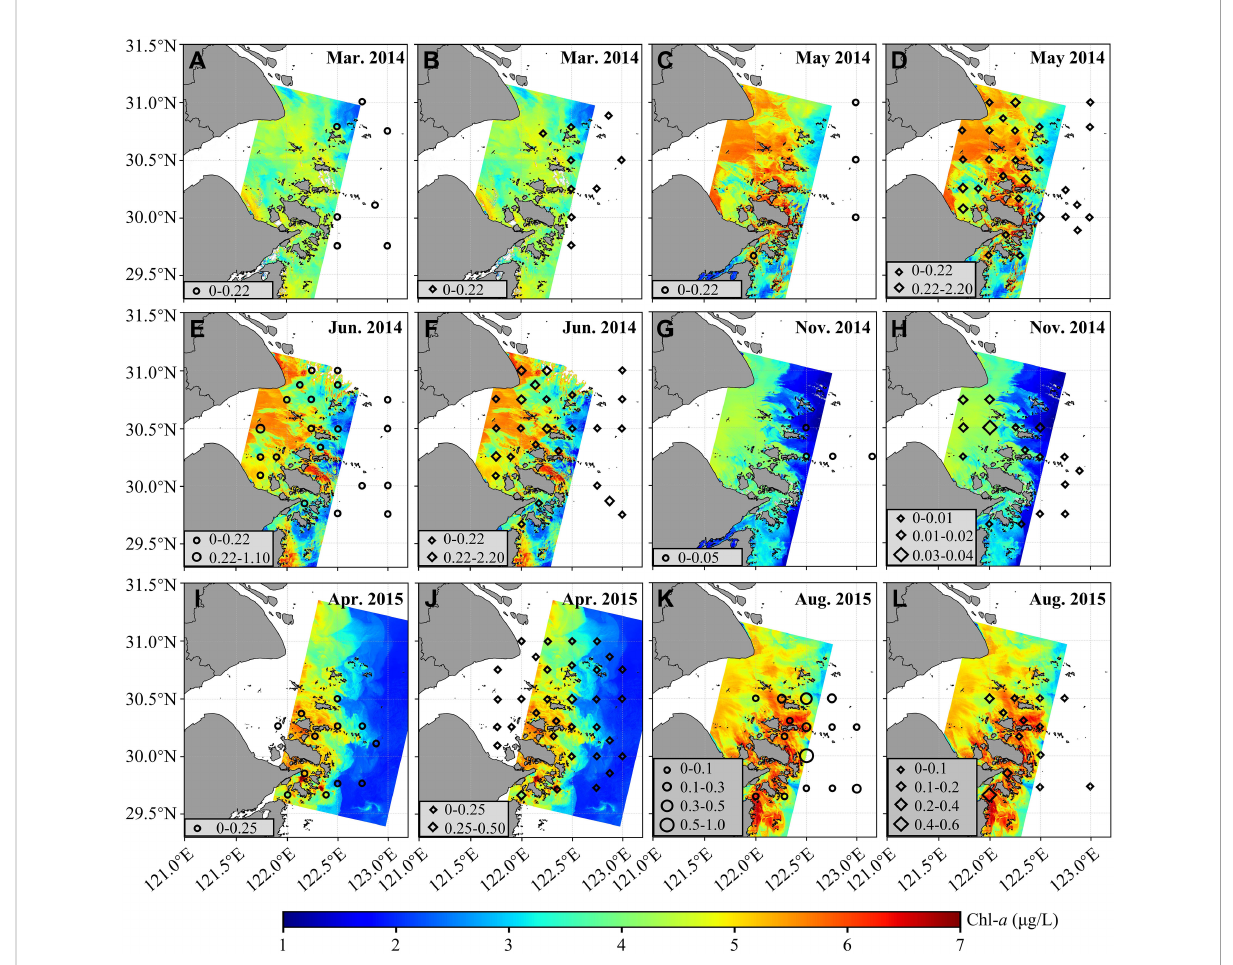
FIGURE 8 The density (ind./m 3 ) of fi sh eggs and larvae in spring, summer and autumn in the water of the Zhoushan archipelago from 2014 to 2015. (A – D) In spring; (E, F) in summer; (G, H) in autumn; (I, J) in spring; (K, L) in summer. Black round dots: larvae; black diamond-shaped dots: fi sh eggs.